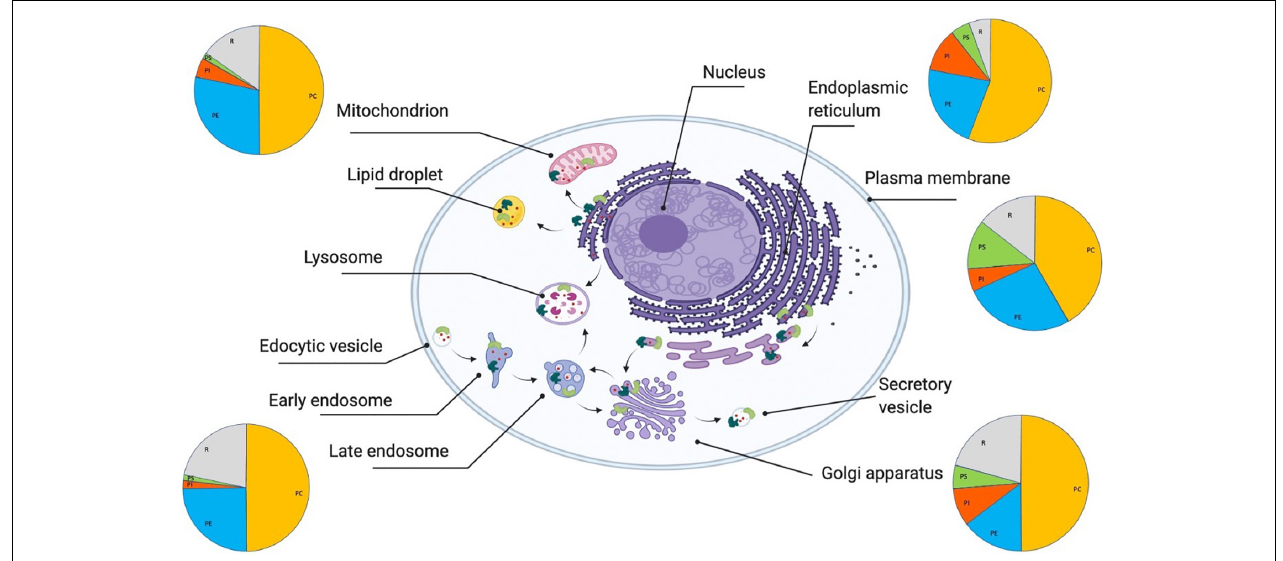
FIGURE 1 | Lipid homeostasis and its links with protein homeostasis. The lipid homeostasis system is the ensemble of cellular processes (indicated by black arrows) that regulate the behavior of lipids (indicated by small red circles) in terms of their synthesis, trafficking, localizations, concentrations, interactions, and degradation (Unger et al., 2010). The lipid membranes of different organelles have different compositions (as indicated schematically by the pie charts). The major structural lipids in mammalian cell membranes are glycerophospholipids (PC, phosphatidylcholine (orange); PE, phosphatidylethanolamine (blue); PI, phosphatidylinositol (red); PS, phosphatidylserine (green), and R:rest (gray)), sphingolipids (sphingomyelin and glycosylceramide), and sterols. These lipid compositions are tightly regulated by a range of lipid-processing proteins, including enzymes (light green) and molecular chaperones (dark green), that perform lipid synthesis, which happens predominantly in the endoplasmic reticulum, Golgi and mitochondria, lipid trafficking, which includes both translocation between the two leaflets of cell membranes (flippases and scramblases) and transport through the secretory pathway, and lipid